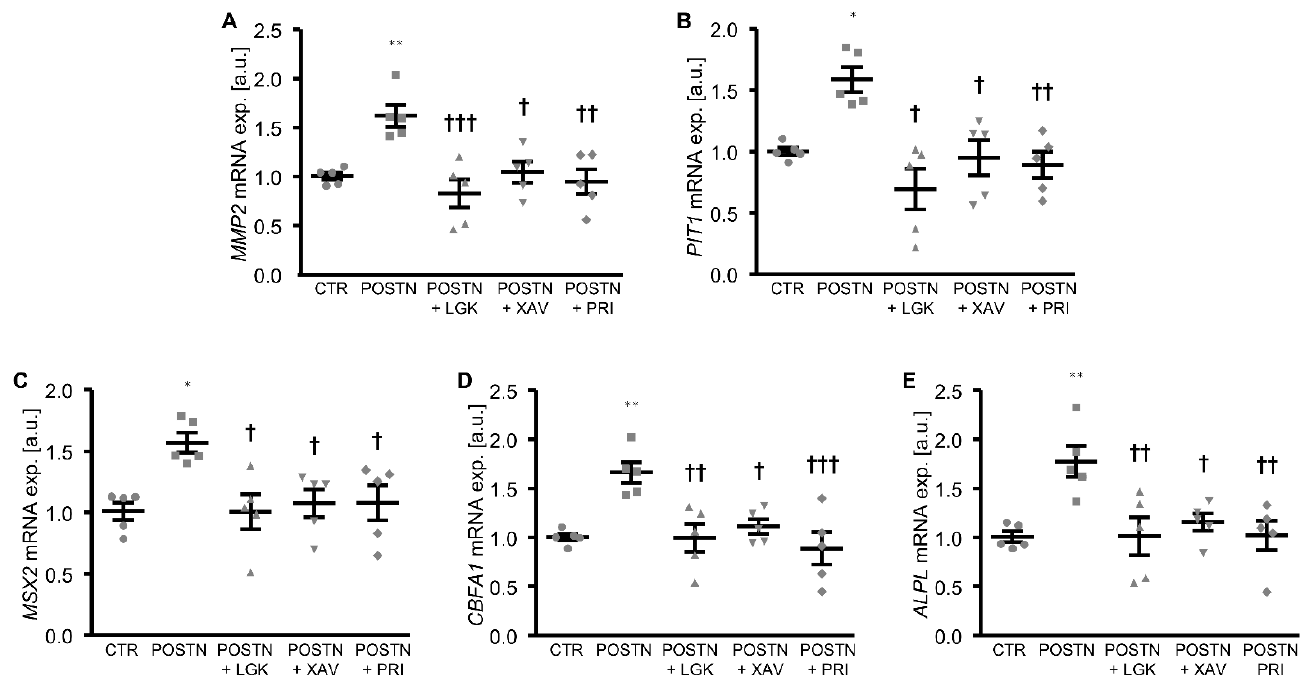
Figure 4. Inhibition of the WNT/ β -catenin pathway suppresses periostin-induced osteogenic signal- ing in HAoSMCs. ( A – E ) Relative mRNA expression of MMP2 ( A ), PIT1 ( B ), MSX2 ( C ), CBFA1 ( D ) and ALPL ( E ) in HAoSMCs treated with control (CTR) or recombinant human periostin (POSTN) without or with additional treatment with the WNT/ β -catenin pathway inhibitors LGK974 (LGK), XAV939 (XAV) or PRI-724 (PRI). * p < 0.05; ** p < 0.01 (significant difference versus CTR group); † p < 0.05; †† p < 0.01; ††† p < 0.001 (significant difference versus POSTN group).